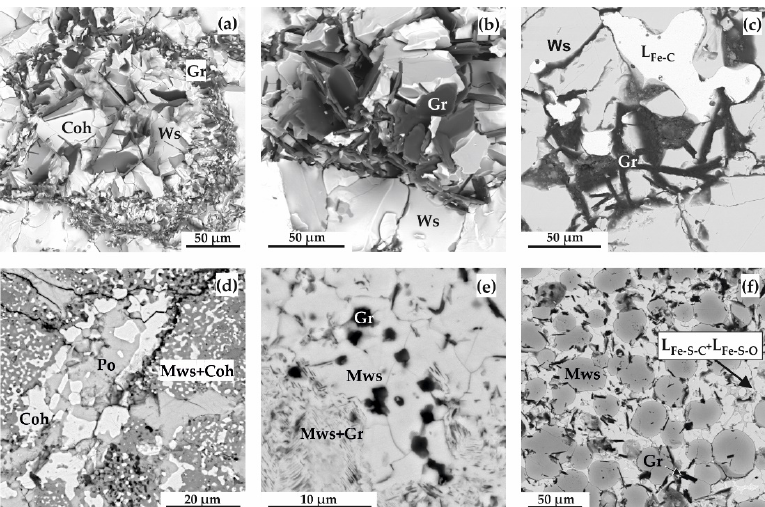
Figure 12. SEM photographs of sample fragments, which were produced in cohenite-hematite ( a – c ) and carbonate-iron-sulphur ( d – f ) systems: ( a ): cleavage surface; graphite and wüstite reaction zone around cohenite (1200 ° С ); ( b ): cleavage surface; graphite crystals in a wüstite aggregate (1500 ° С );